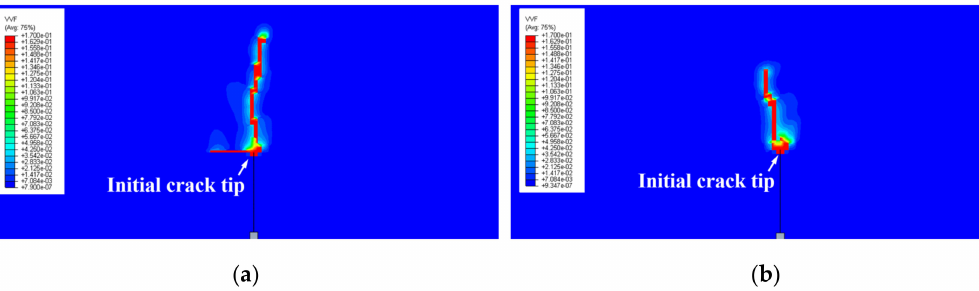
Figure 9. The crack propagation paths of all the second crack-branching models.